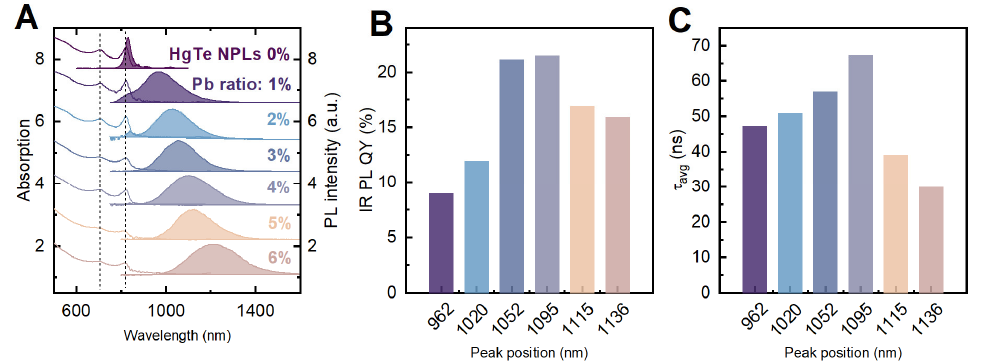
Figure 4. Optical properties of HgTe:Pb nanoplatelets with different lead ratios: ( A ) photoluminescence and absorption spectra; ( B ) near-infrared band PL QY vs. its peak position; ( C ) averaged near-infrared photoluminescence decay times vs. peak positions.